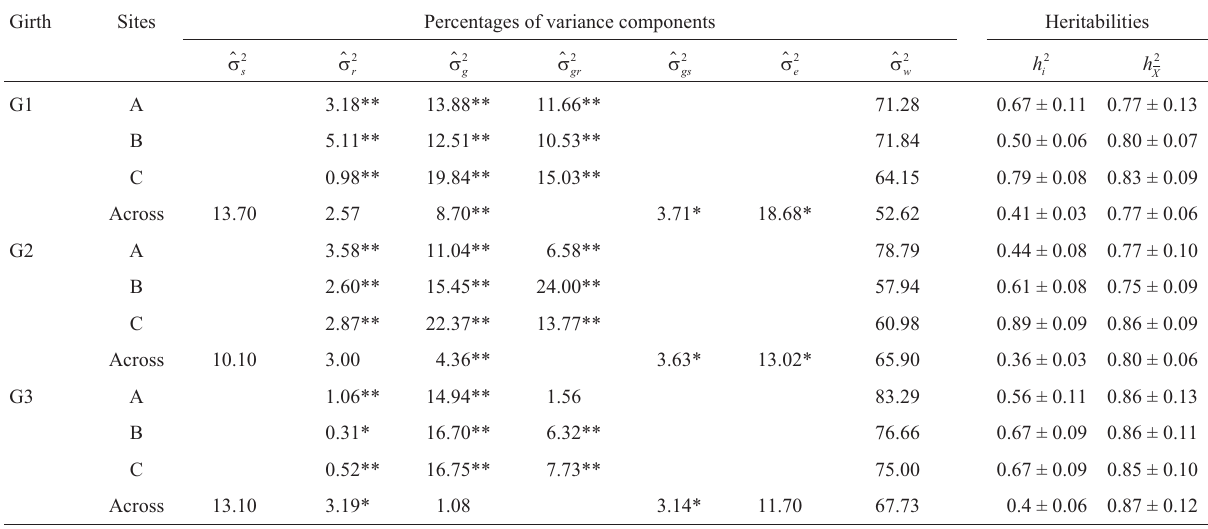
Table 3 - Site-related percentages of the variance components and heritabilities for increased girth in 22 open pollinated Hevea progenies growing at three sites (Votuporanga (A), Pindorama (B) and Jaú (C)) in the Brazilian state of São Paulo. Girth measured when the trees were one (G1), two (G2) and three (G3) years